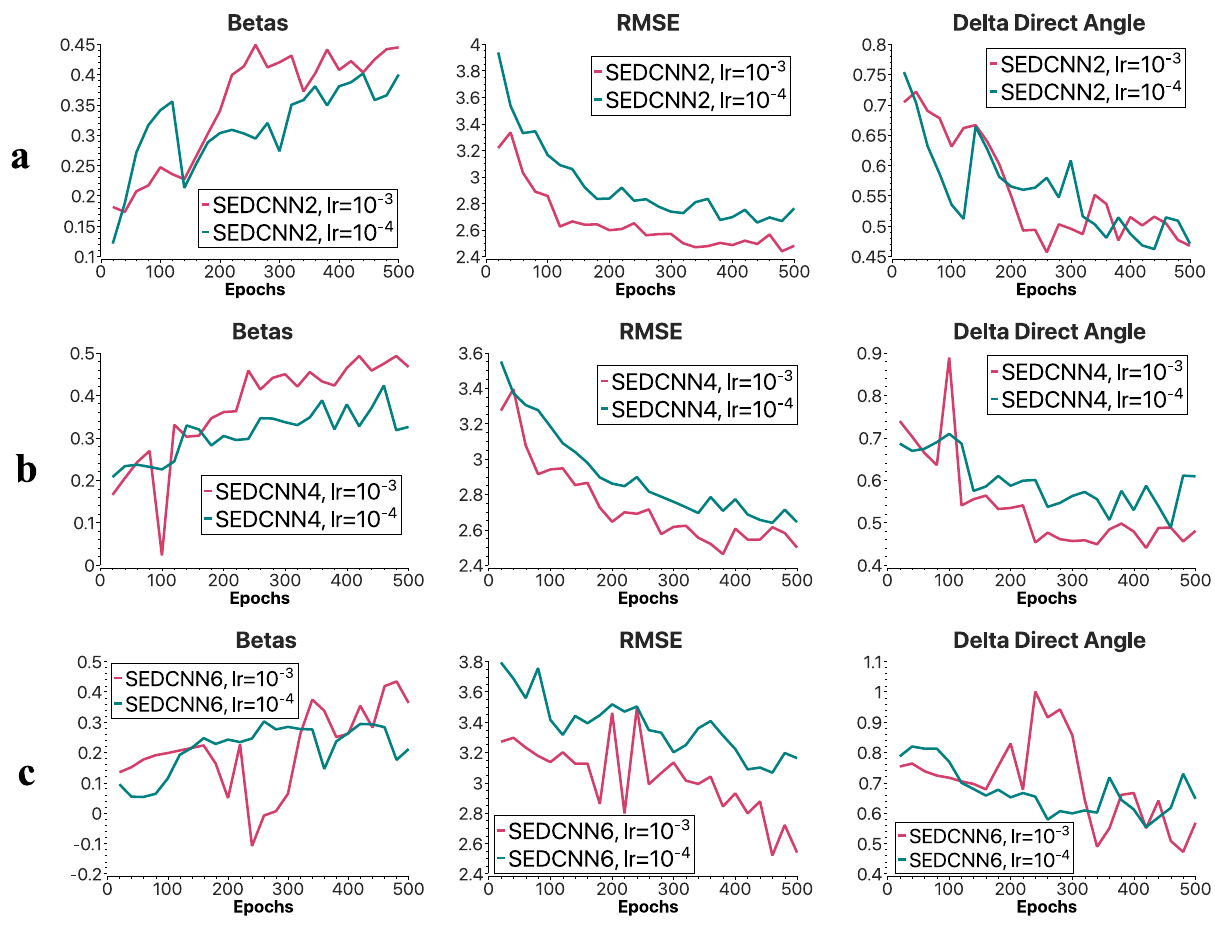
Fig. 6 Performance under different learning rate. Betas, RMSE, Delta Direct Angle estimates using a SEDCNN2, b SEDCNN4 and c SEDCNN6 with varying learning rates. Here, three major SEDCNN variants were compared in terms of learning rate change. Units for Betas and RMSE were arbitrary, and degrees for Delta Direct